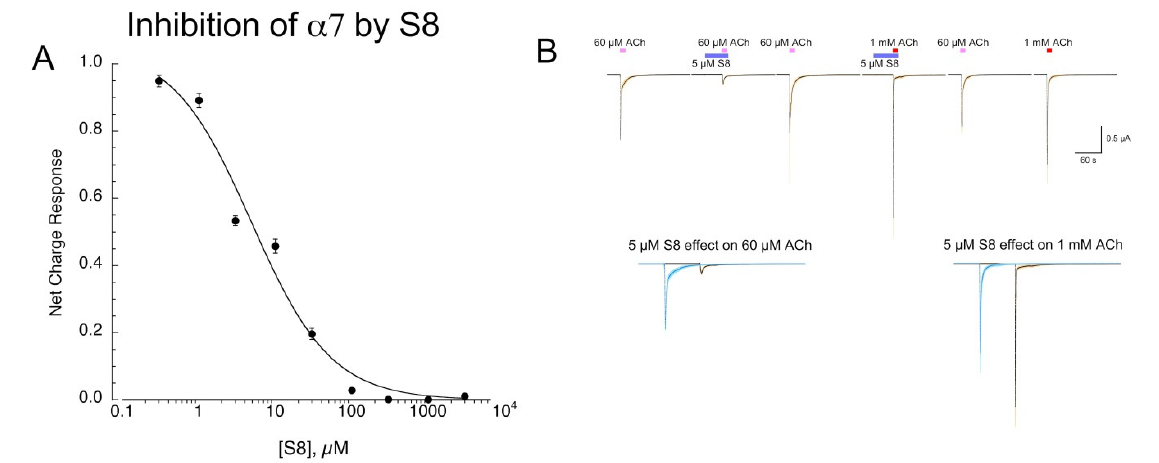
Figure 5. Inhibition of α 7 ACh-evoked responses by S8 . ( A ) Concentration-response studies of α 7 net-charge responses to 60 µ M ACh co-applied with increasing concentrations of S8 . To confirm the stability of the ACh responses, applications of ACh plus S8 were alternated with applications of ACh alone. Data are the averages of eight cells ( ± SEM). See text for curve-fit values. ( B ) Effects of 5 µM S8 on responses to either 60 µM or 1 mM ACh. The traces shown across the top are the averaged raw data from seven cells, each normalized to the peak current of the first ACh control response shown. In order to assure that the S8 was present at 5 µM throughout the ACh-evoked responses, a 30 s pre-application was made of 5 µM S8 alone. The lower traces show averaged responses to 60 µM or 1 mM ACh alone or with the 5 µM S8 pre- and co-application. The details of the data are described in Methods.